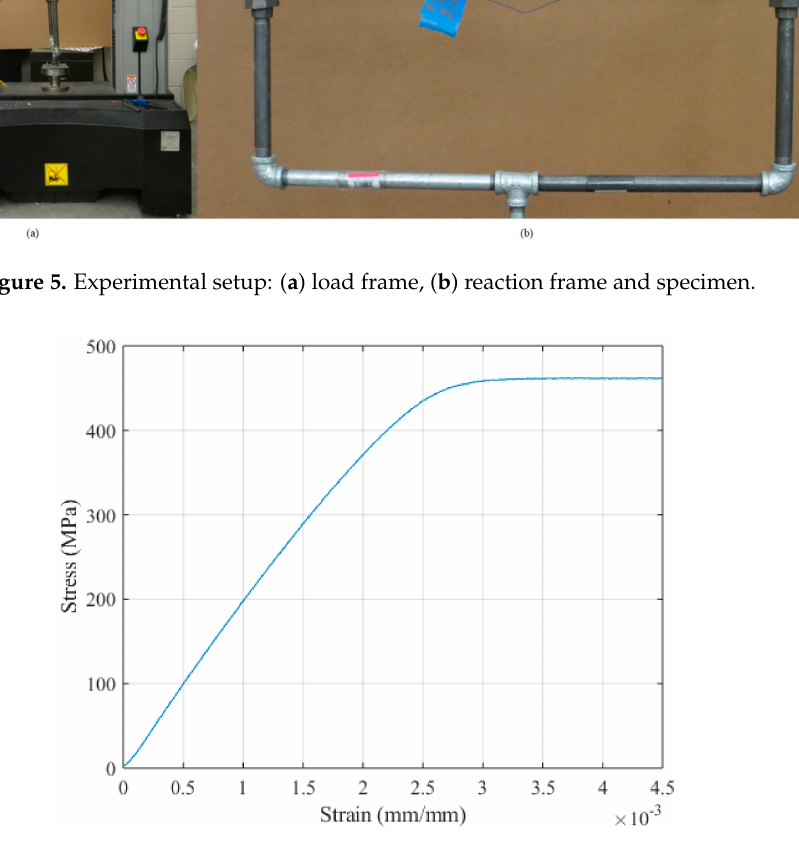
Figure 6. Stress–strain curve for Configuration 1